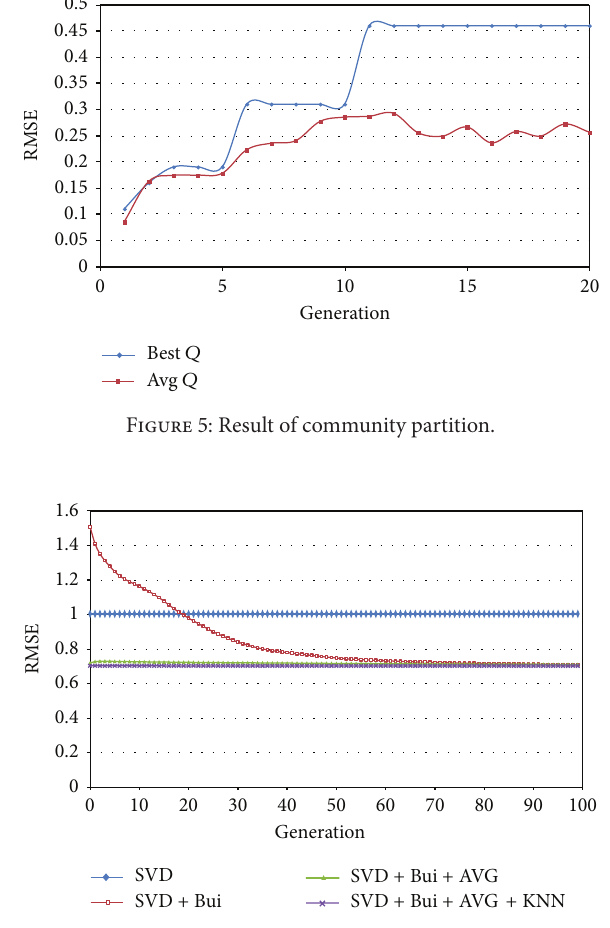
Figure 6: RMSE of proposed algorithm and basic SVD.